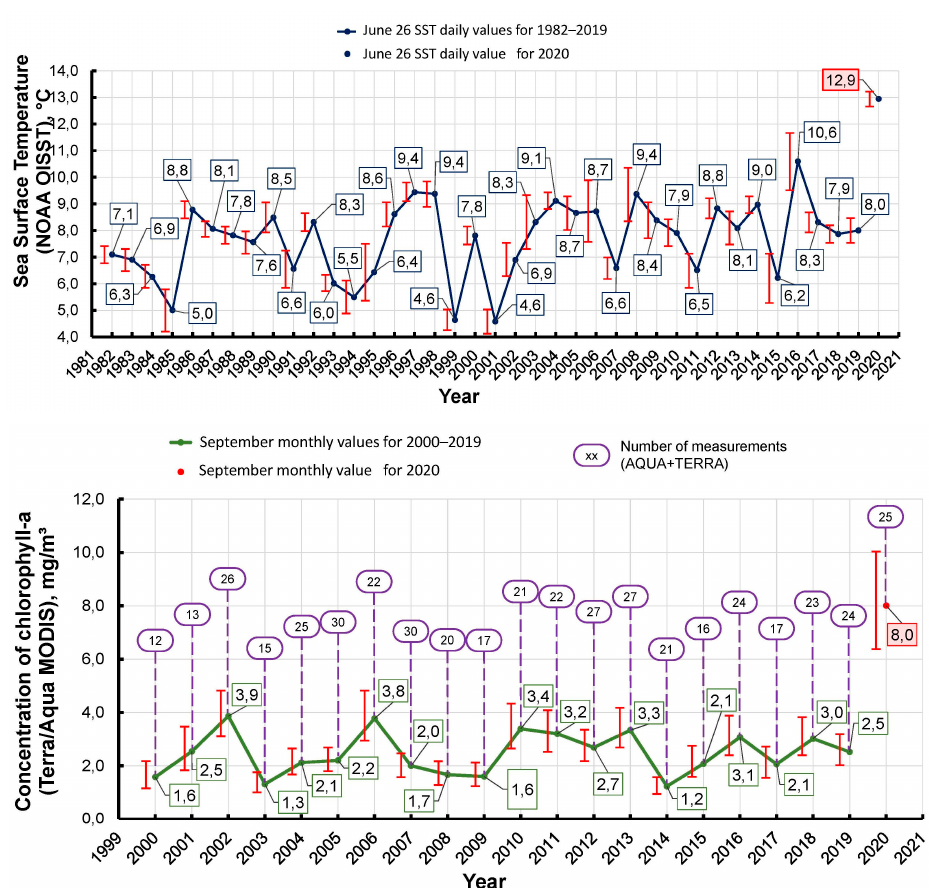
Figure 10. Annual variability of parameters averaged over the area of the study region: top, 27 June SST daily values for 1982–2020; bottom, September chlorophyll-a monthly values for 2000–2020. Red segments denote confidence intervals (95%).